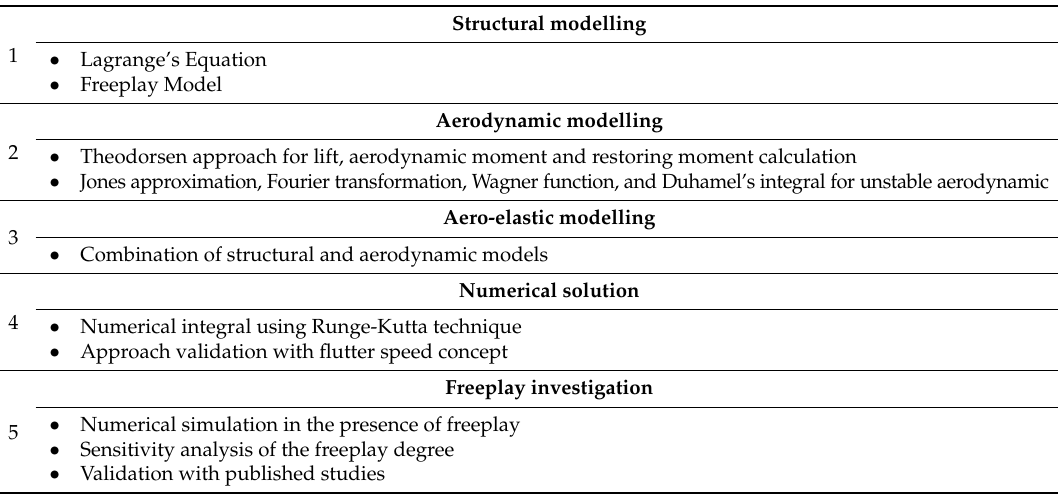
Table 2. Proposed method